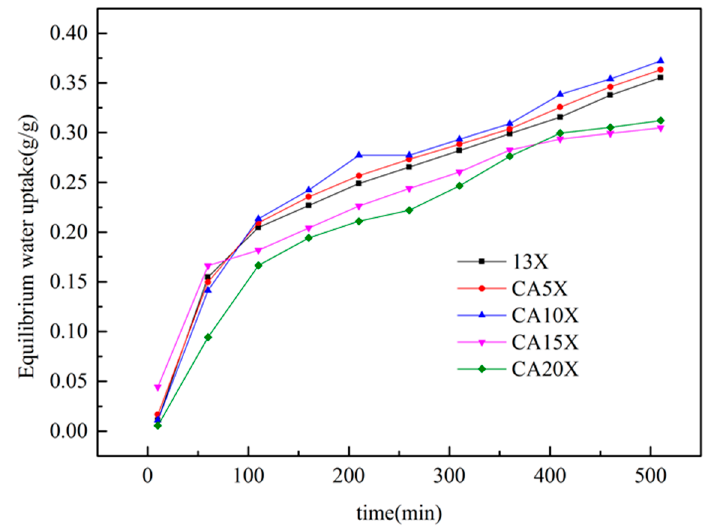
Figure 10. Equilibrium water uptake changes with time.